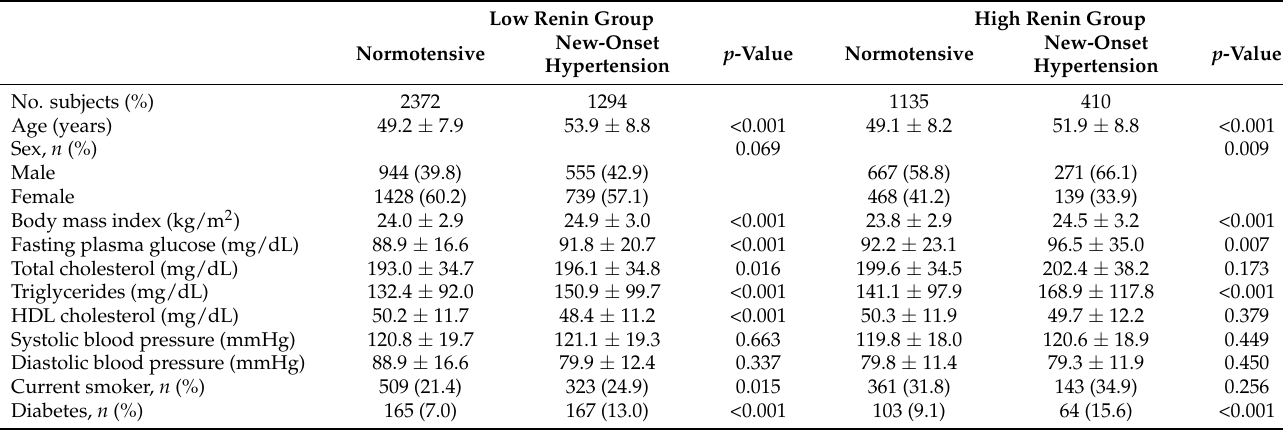
Table 1. Baseline characteristics of the study